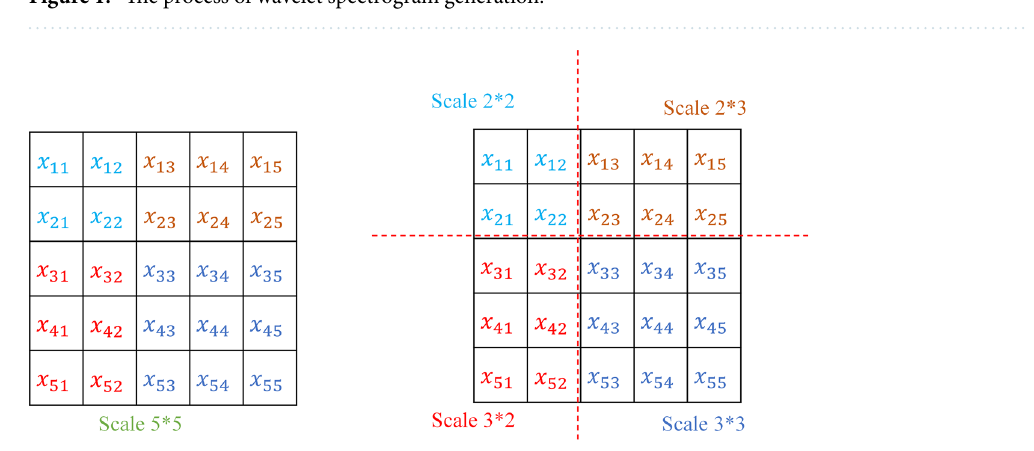
Figure 1. The process of wavelet spectrogram generation.